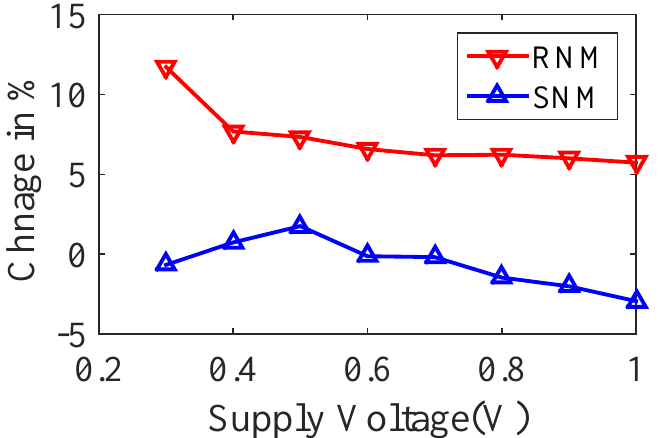
Figure 21. % change in the SNM and RNM of RSWA12T SRAM cell compared with state-of -the-art SRAM